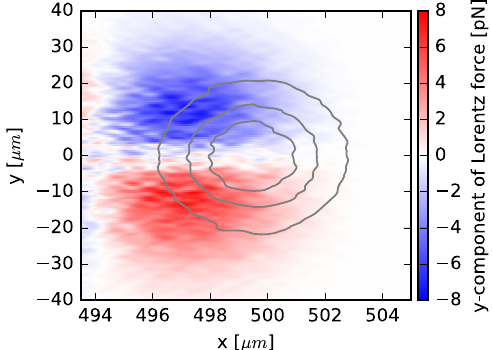
FIG. 5. The Lorentz force focusing the electron bunch: A central slice of the 3D simulation data is shown along z ¼ 0 after a propagation of 500 μ m through the plasma. The gray contour ffiffiffi p 2 lines indicate 1 = , 1 = 2 and 1 = 4 of the maximum bunch density. The electron bunch is moving towards þ x direction and expe- riences a focusing Lorentz force (color scale). Although the strongest fields are present in the tail of the bunch, the first half of it still experiences a significant amount of